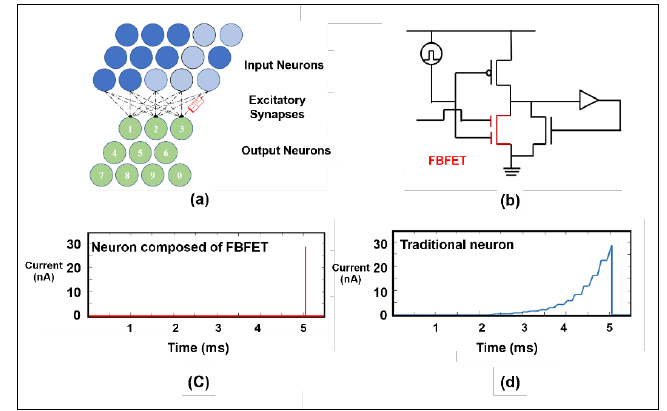
Figure 13. ( a ) Illustration of pattern classification with a spiking neural network and ( b ) the proposed neuron circuit diagram for a capacitorless structure with FBFETs for “integration -and- fire” [55,91]. ( c , d ) Transient currents flowing through the trigger device in three different neurons when the same number of input pulses are provided to the neuron circuit [21].